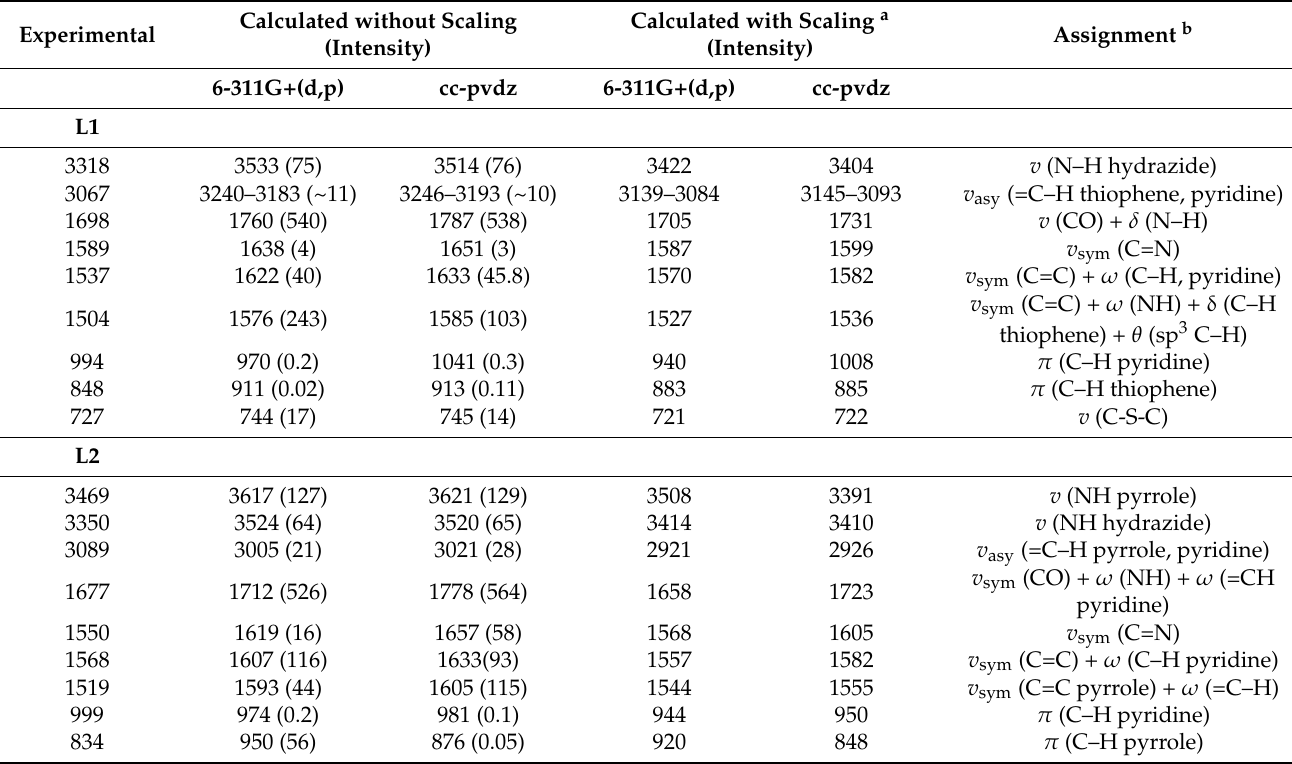
Table 2. Experimental and calculated (with and without scaling) vibrational frequencies (cm − 1 ) of L1 and L2